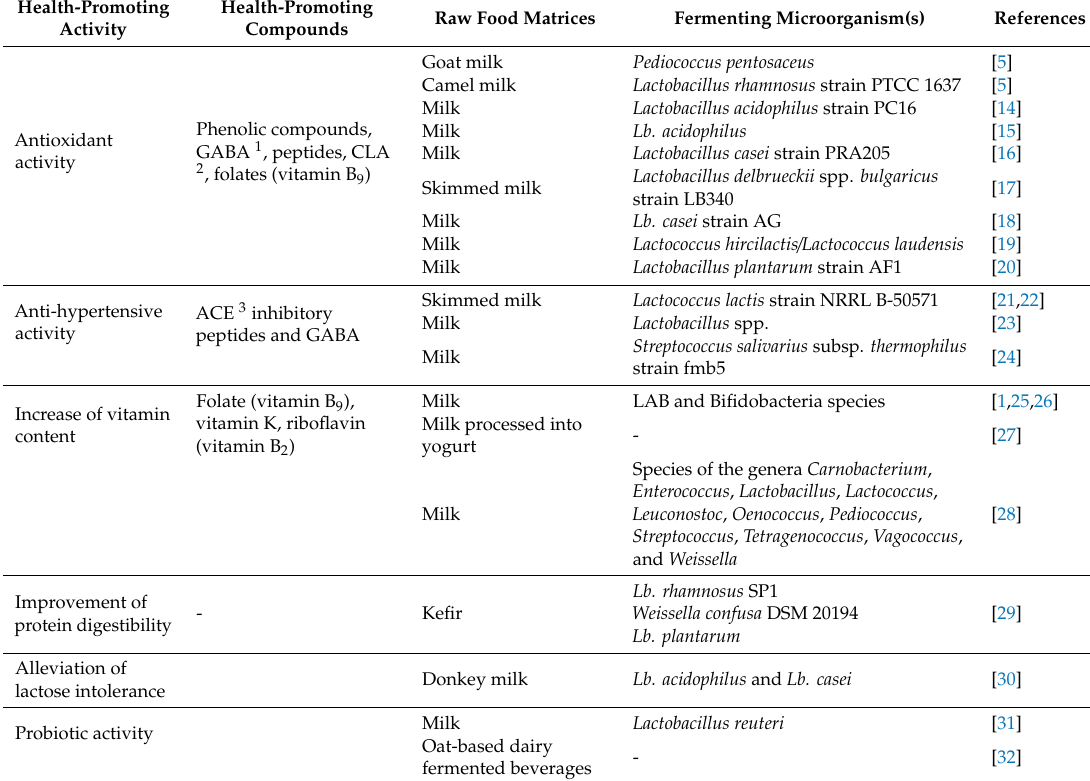
Table 2. Health-promoting compounds in fermented